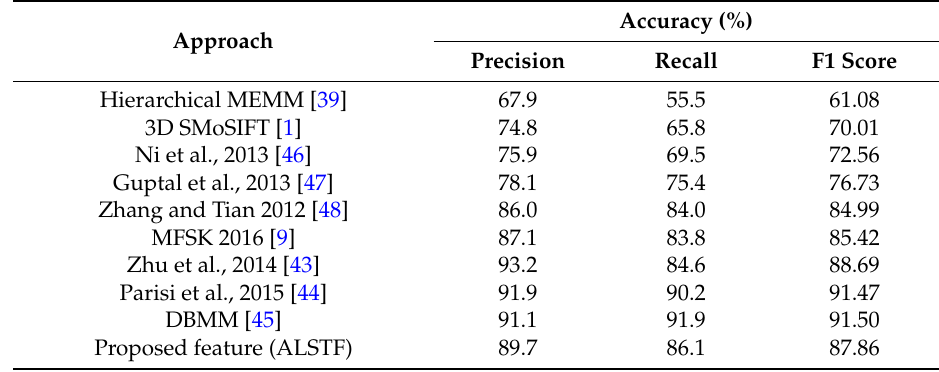
Table 7. The performance comparison of several state-of-the-art approaches on the CAD-60 dataset under leave-one-out cross validation setting.